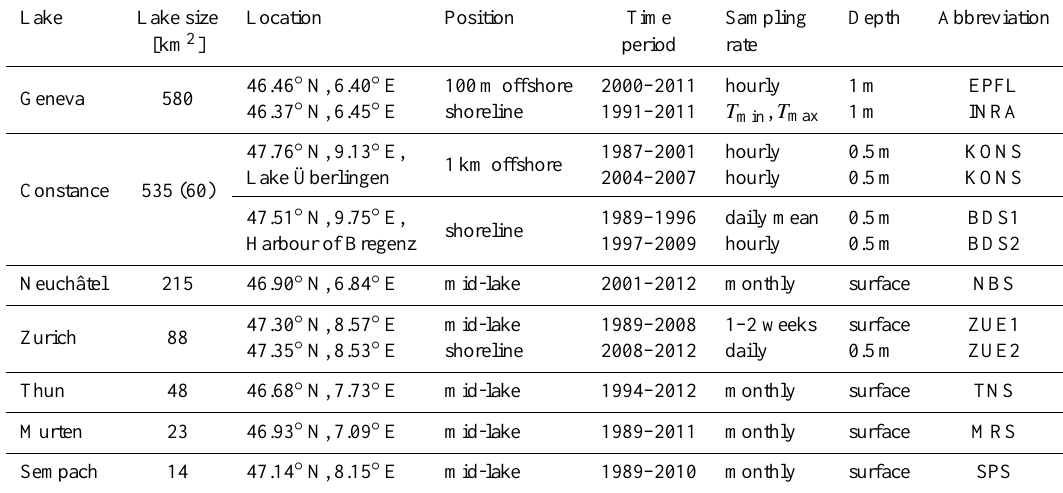
Table 2. Summary of lakes and locations with in in situ observations of water temperatures used for the inter-comparison with the satellite retrieval. The two values for the size of Lake Constance indicate the area of the entire lake and the area of the subsection of Lake Überlingen. Abbreviations for the various locations are used to easily identify the chosen data